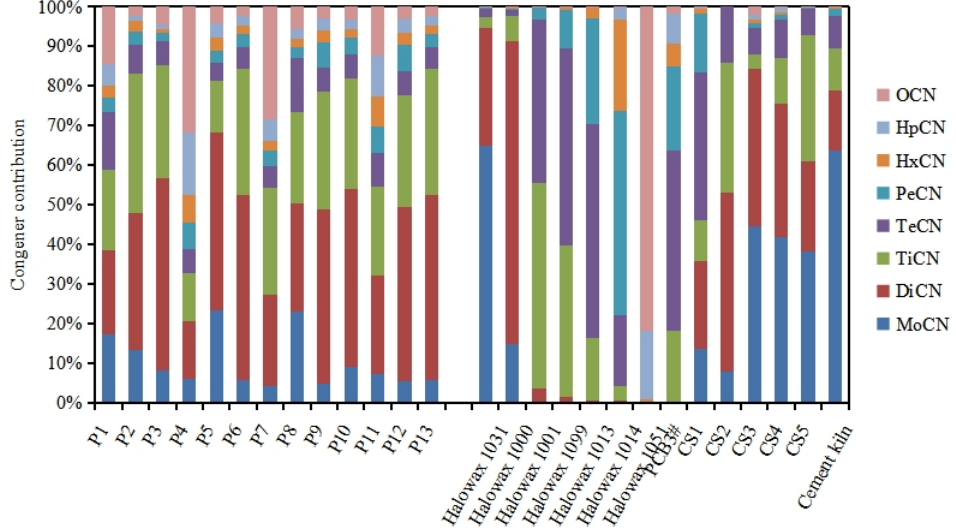
Figure 3. PCN patterns in the soil samples (P1–13), flue gas samples from five converter steel plants (CS1–5) [51] and a cement kiln [52], seven commercial PCN formulations (Halowax 1000, 1001, 1013, 1014, 1031, 1051, and 1099) [19], and a commercial PCB formulation (PCB 3#) [47].